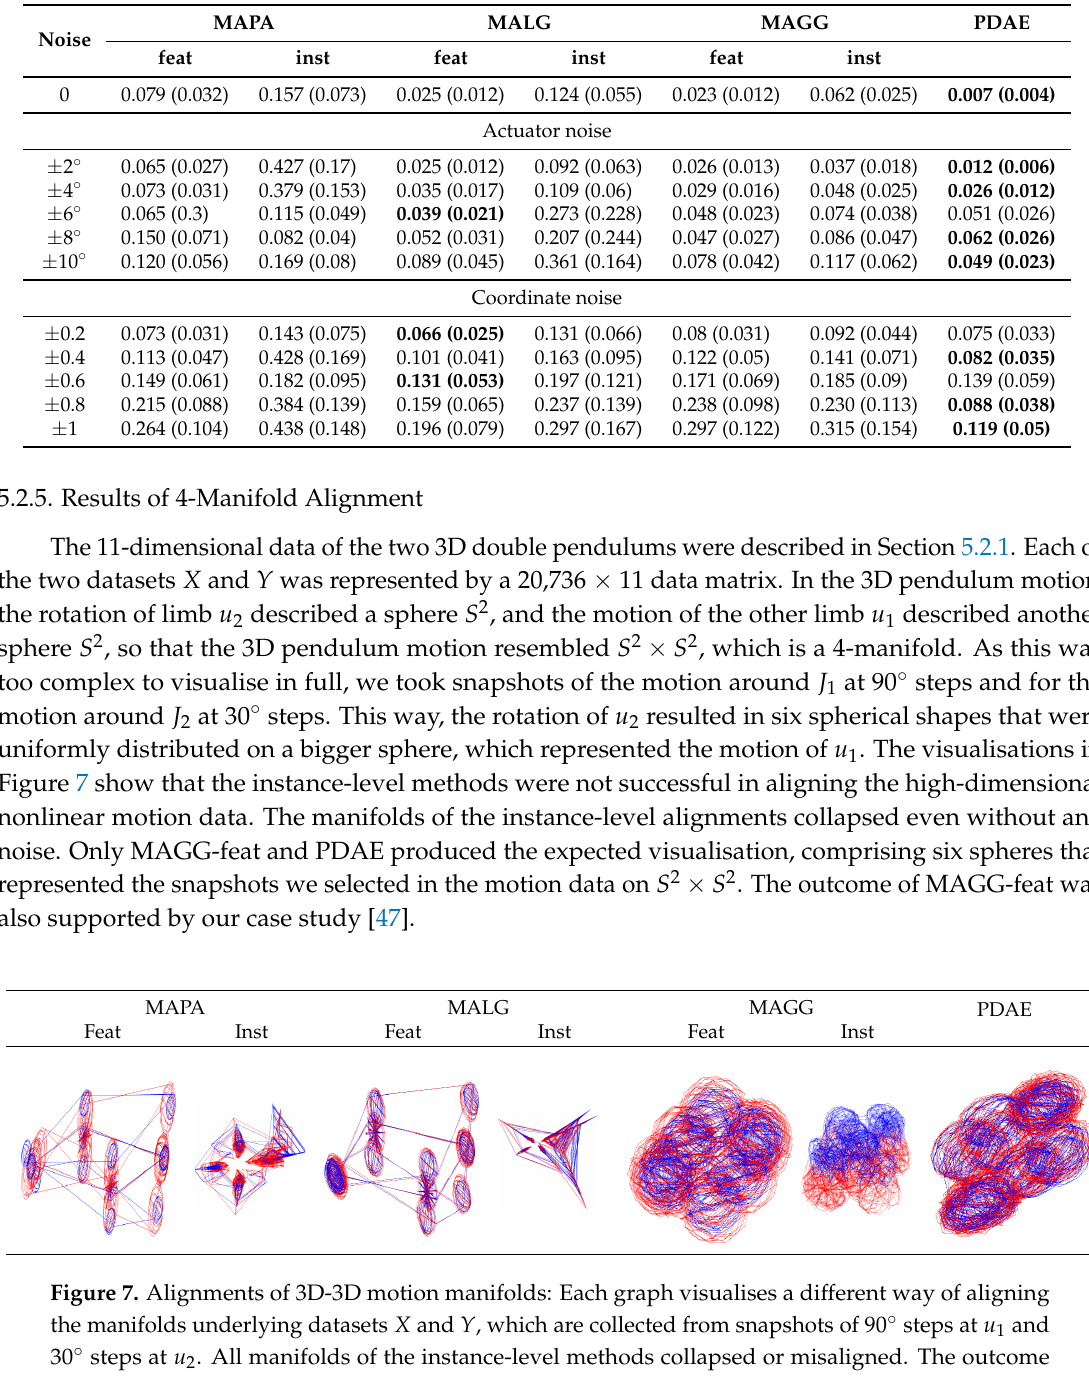
Table 3. 2D-3D manifold alignment: Alignment errors with standard deviations as explained in Table 2.